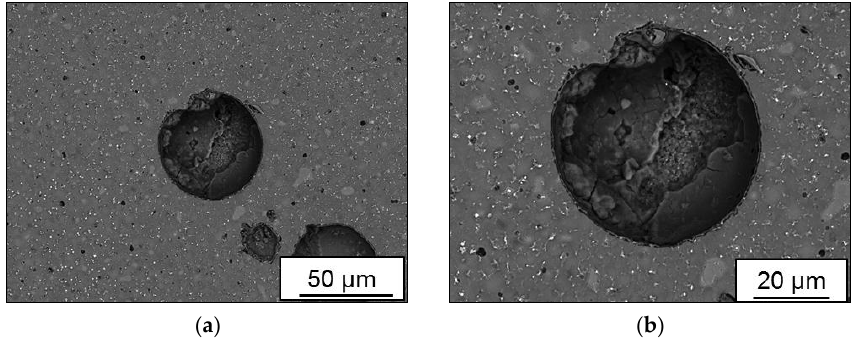
Figure 8. Pore morphology in batch C (Scalmalloy ® LMD): ( a ) 500X; ( b ) 1000X.